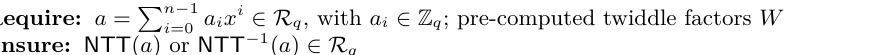
Algorithm 5 Memory-efficient and unified CT-GS-NTT